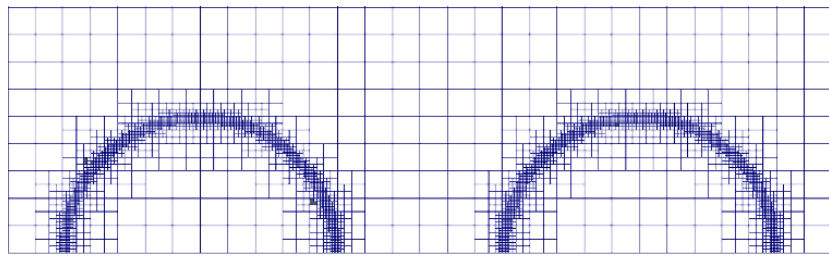
Figure 3. The adaptive mesh generated by interDyMFoam.